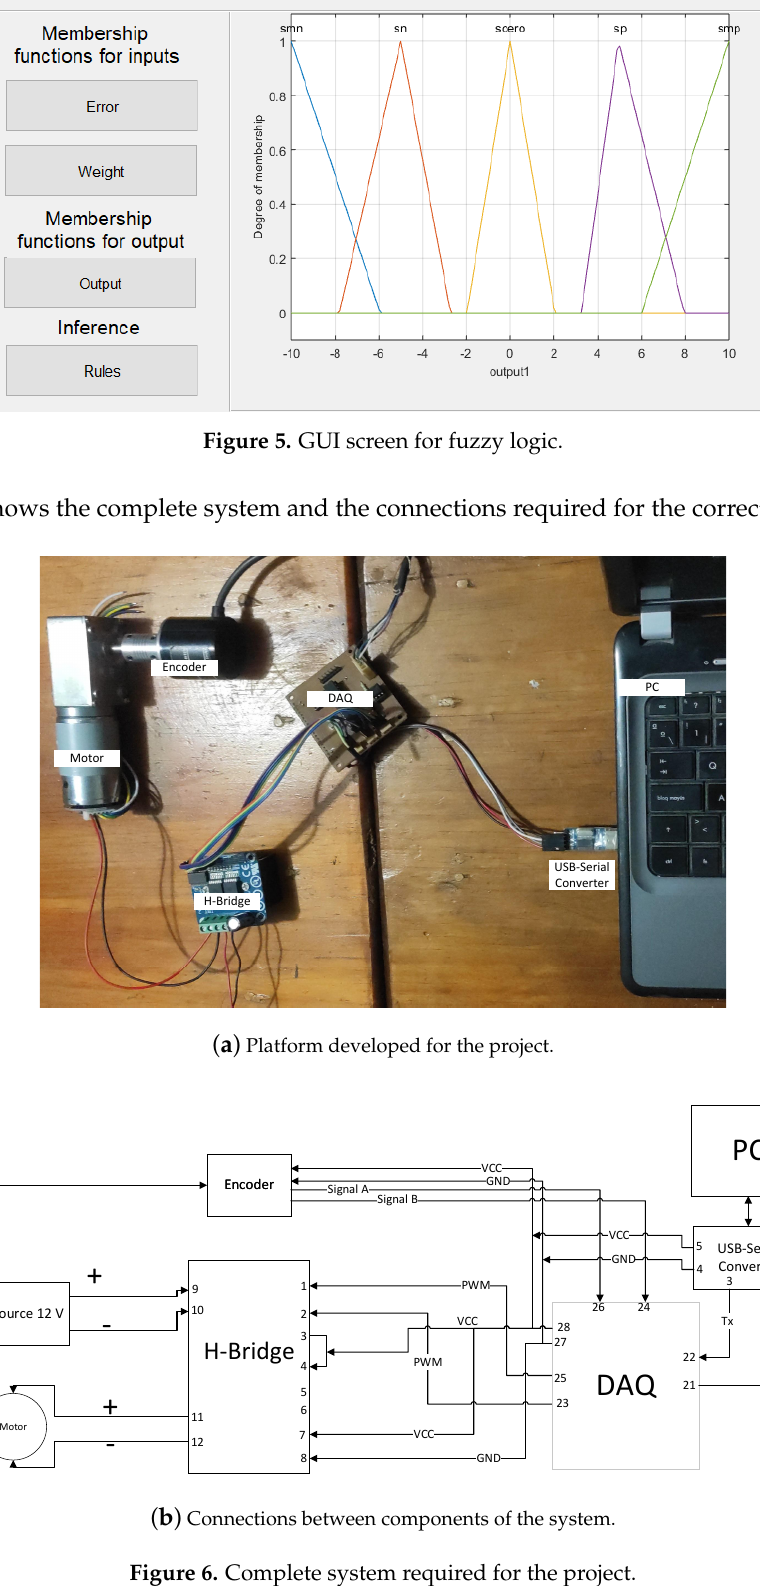
Figure 6. Complete system required for the